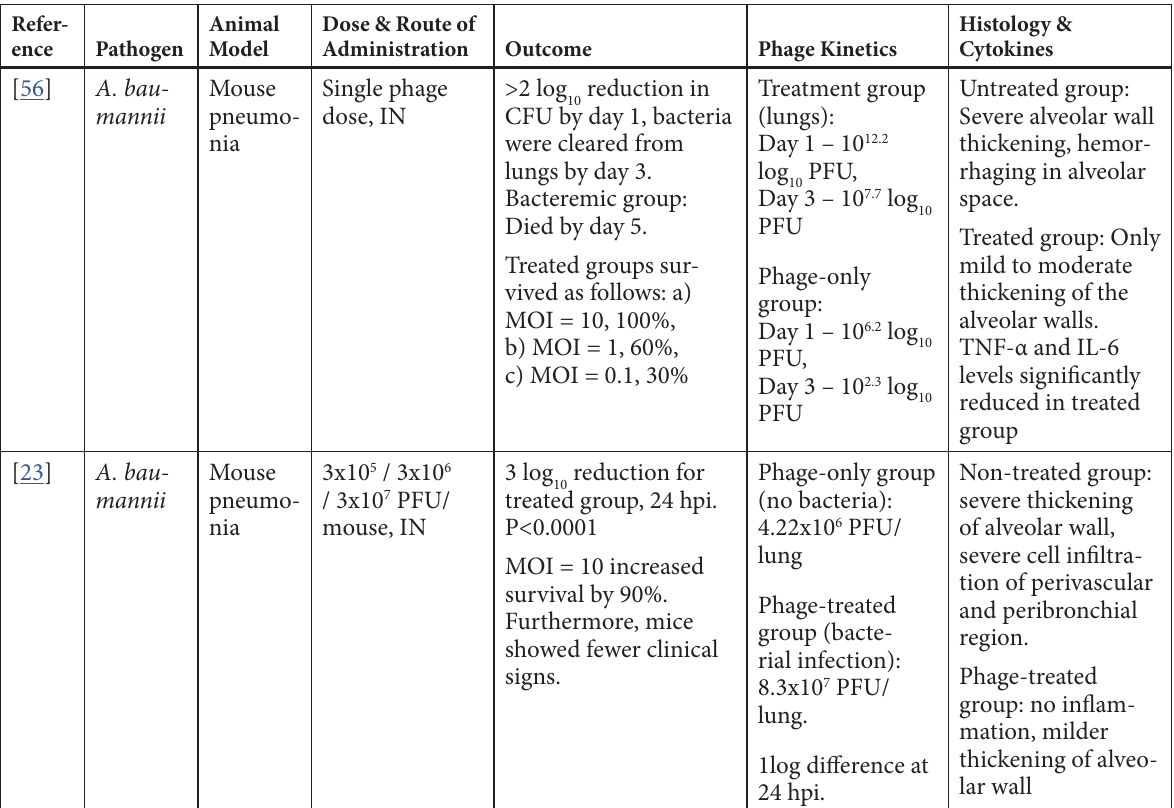
Table 1. Animal Pneumonia